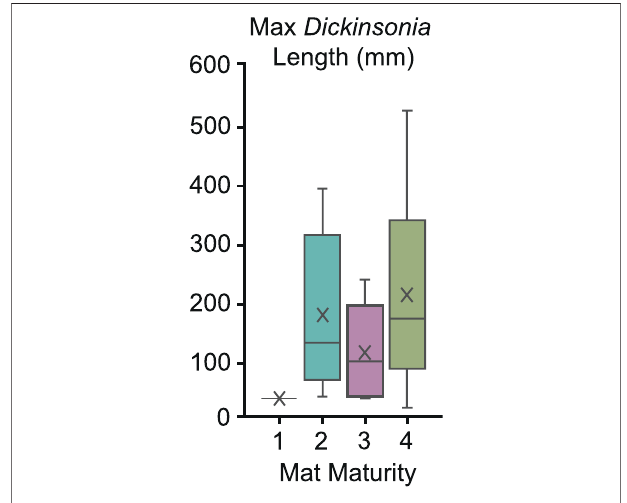
FIGURE 10 | Box and whisker plot demonstrating the relationship between Dickinsonia body size and mat